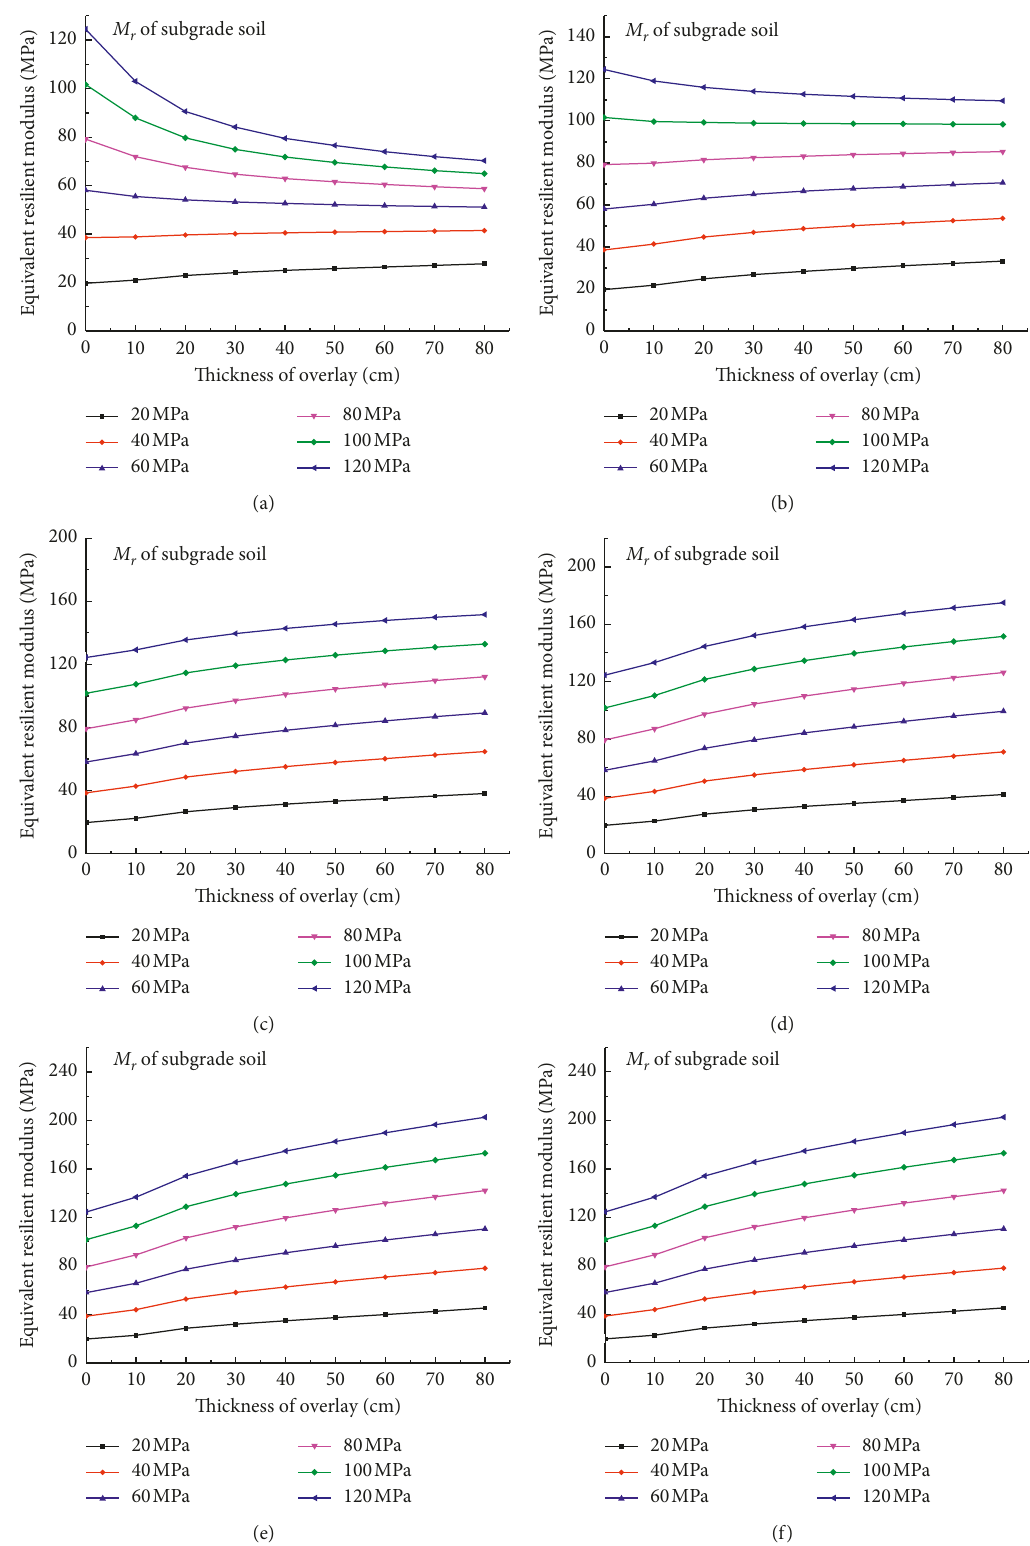
Figure 4: Equivalent resilient modulus with different M r of subgrade soil and overlay. The M r of the overlay is (a) 50MPa, (b) 100MPa, (c) 200MPa, (d) 300MPa, (e) 400 MPa, and (f)